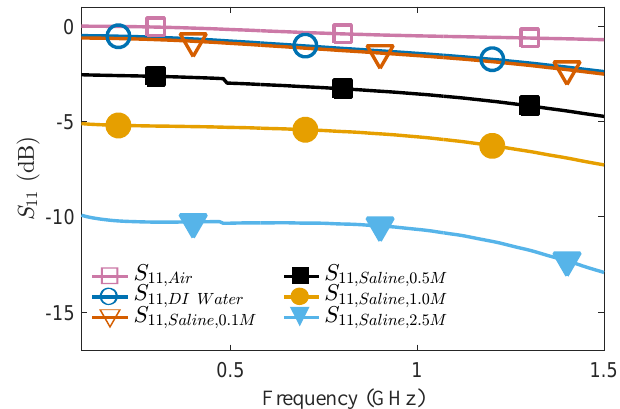
Figure 6. Measured S 11 of the proposed IDC sensor loaded with saline solutions of different